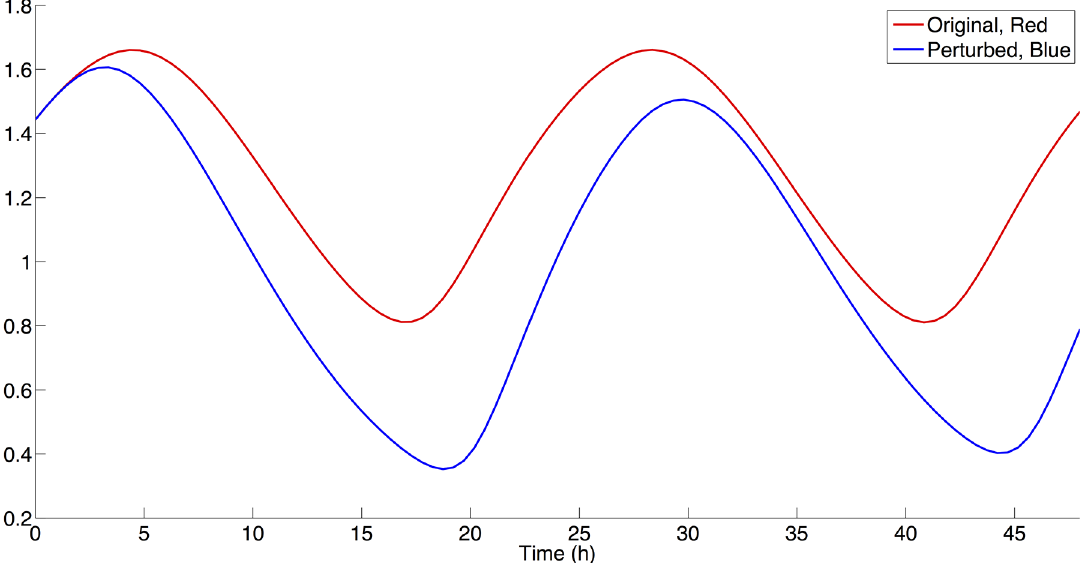
Fig 7. The effect of SIRT1 inhibition on non-histone components on CRY/PER mRNA levels. Red: Simulation using parameter values from Table 2. Blue: Simulation using parameter values from Table 2 with a 25% decrease in VSIRT1c